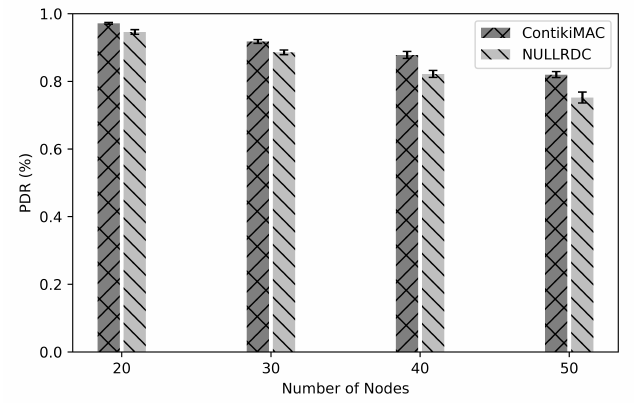
Figure 13. Lookups Packet Delivery Ratio (PDR) as a function of network size.